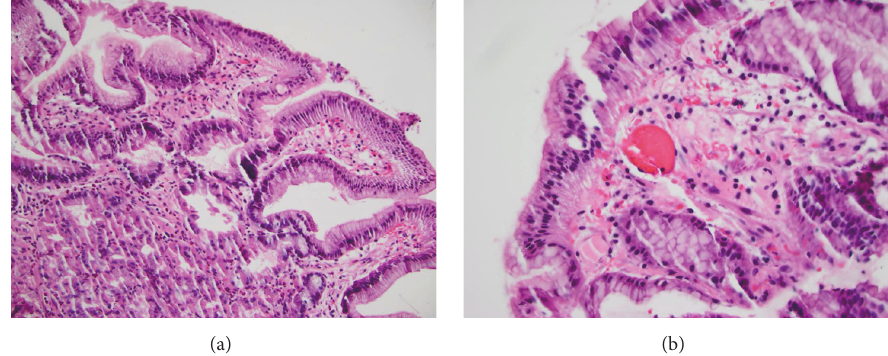
Figure 2: Duodenal biopsies demonstrating oxyntic gastric glandular cells (specialized acid secreting) underlying gastric foveolar epithelium on the surface, no goblet cells or enterocytes to identify it as intestinal (a), and presence of dilated and ectatic blood vessels with mild vascular congestion, features characteristic of GAVE